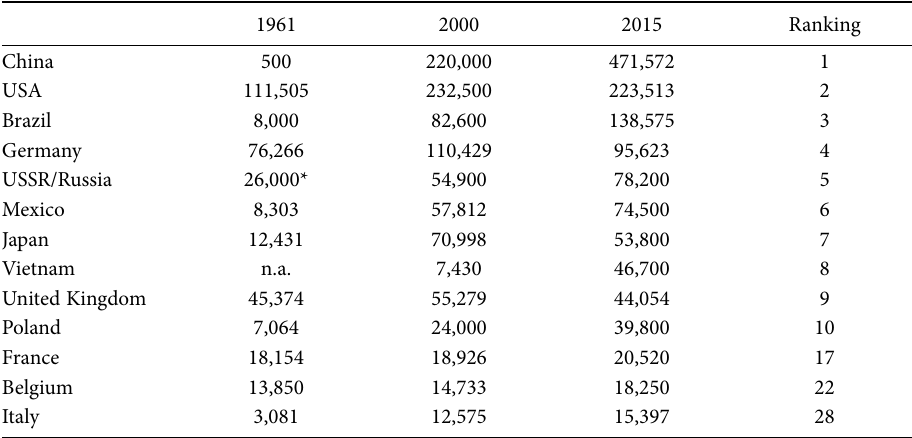
Table 1. Beer production by country (1,000 hl; 1961, 2000,